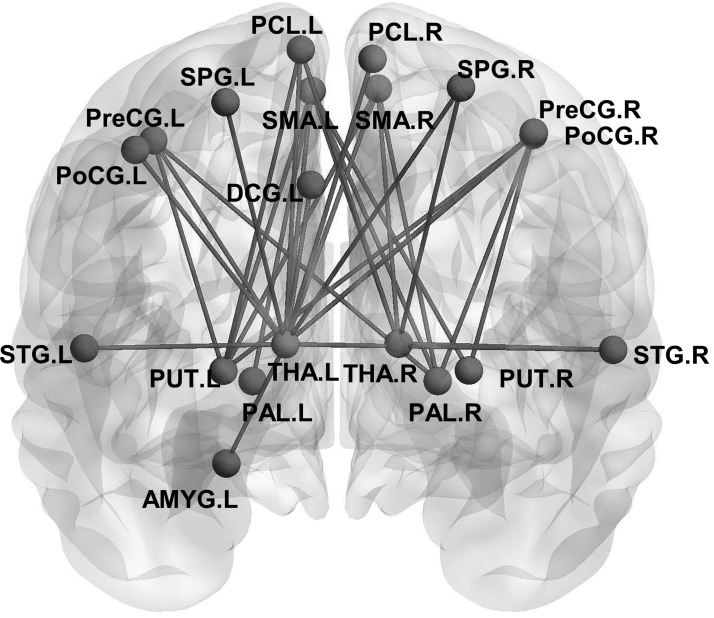
Decreased region-to-region functional connectivity in obese subjects. Comparison of
region-to-region connectivity using network-based statistics controlling for
multiple comparisons (p < 0.05, network-based statistics)
(Automated Anatomical Labeling atlas with 90 brain regions; AAL90 atlas). This
network represents decreased connectivity in all obese subjects compared with
healthy controls. L, Left; R, right; PCL, paracentral lobule; SPG, superior parietal
gyrus; PreCG, precentral gyrus; SMA, supplementary motor area; PoCG, postcentral
gyrus; DCG, middle cingulate gyrus; STG, superior temporal gyrus; PUT, putamen; THA,
thalamus; PAL, pallidum; AMYG, amygdala.